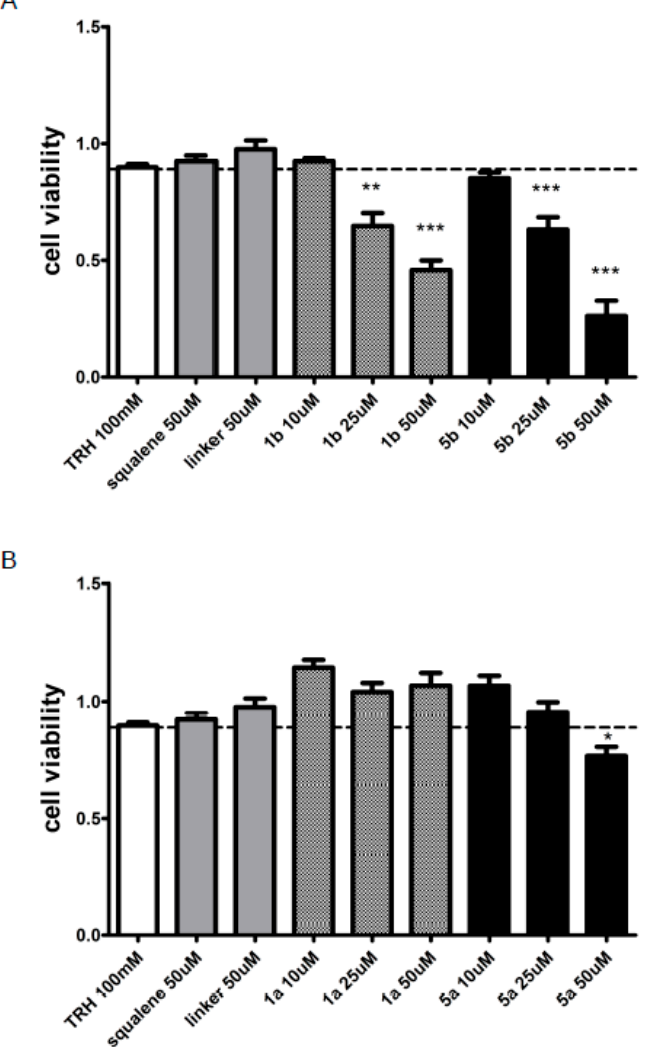
Figure 1. Assessment of the cellular toxicity induced by trehalose, conjugates 1a and 1b and NAs 5a and 5b . We evaluated cell viability upon compound treatment by MTT. ( A ) Cytotoxicity assay on HeLa cells treated for 24 h with trehalose, squalene, 4,4’-dithiodibutyric acid (linker), 1b and 5b . Data are presented as mean ± SE; *** p < 0.001, ** p < 0.01, * p < 0.05 vs. trehalose, n = 10–15. ( B ) Cytotoxicity assay on HeLa cells treated for 24 h with trehalose, squalene, linker, 1a and 5a . Data are presented as mean ± SE * p < 0.05 vs. trehalose, n =